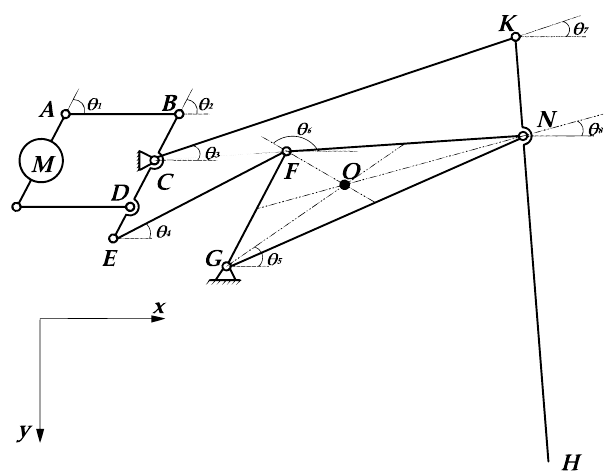
Figure 7. Leg dynamics analysis